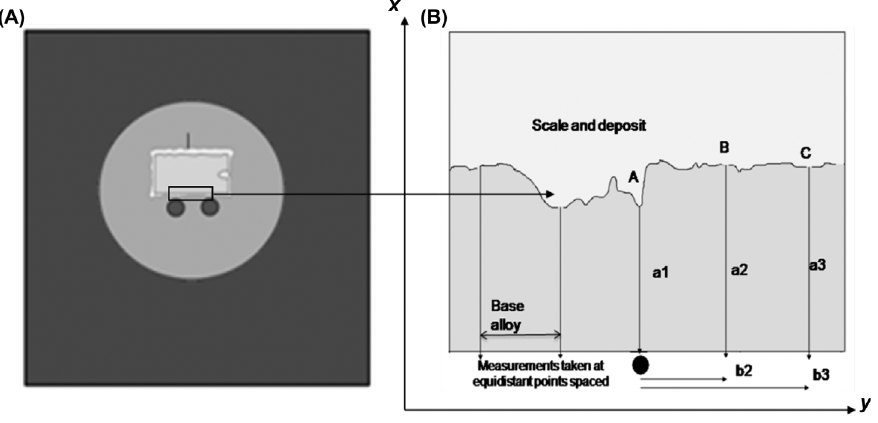
Figure 4: Illustration of function of image analyser. (A) Stage and sample, (B) determining metal loss from the images recorded.